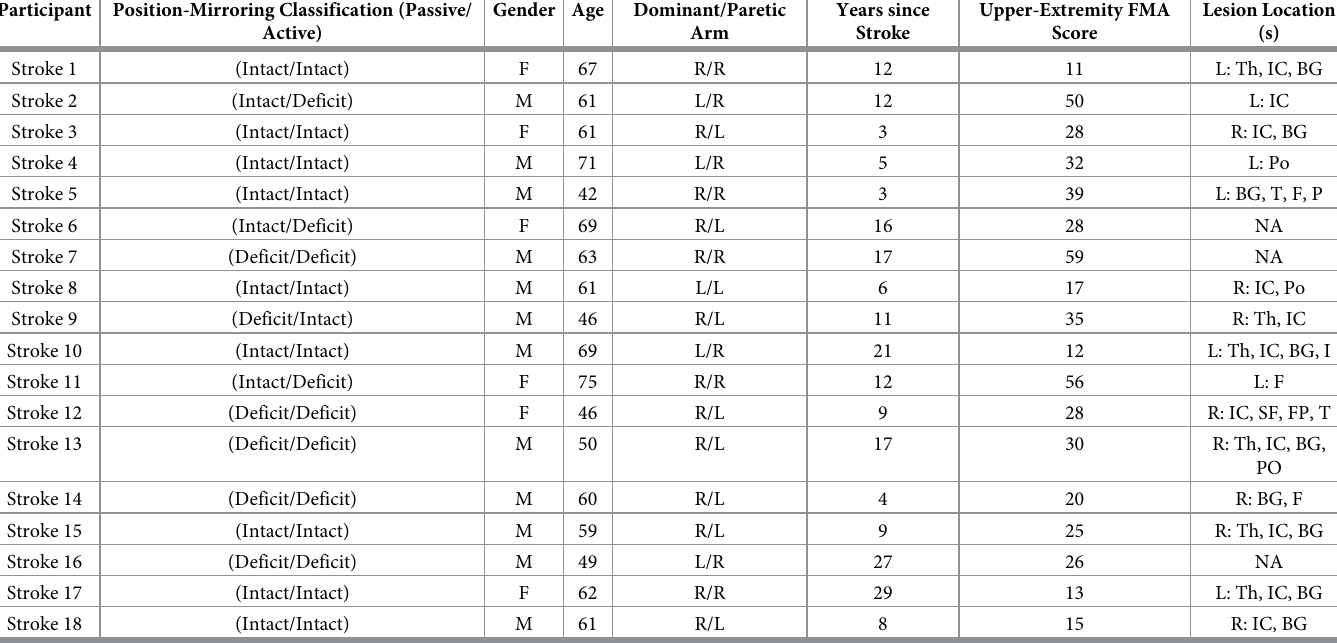
FMA: Fu¨gl-Meyer Motor Assessment, Min: minimum, Max: maximum, NA: information not available, Th: thalamus, IC: internal capsule, BG: basal ganglia, F: frontal coronoradiata.